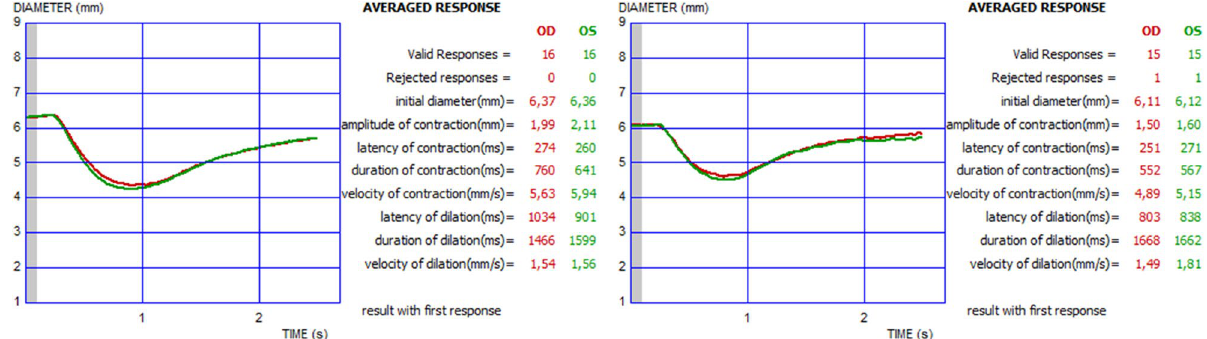
Figure 4. Binocular pupillary light reflex responses measured with dynamic pupillometry in a healthy subject (left), and a patient with Fabry disease